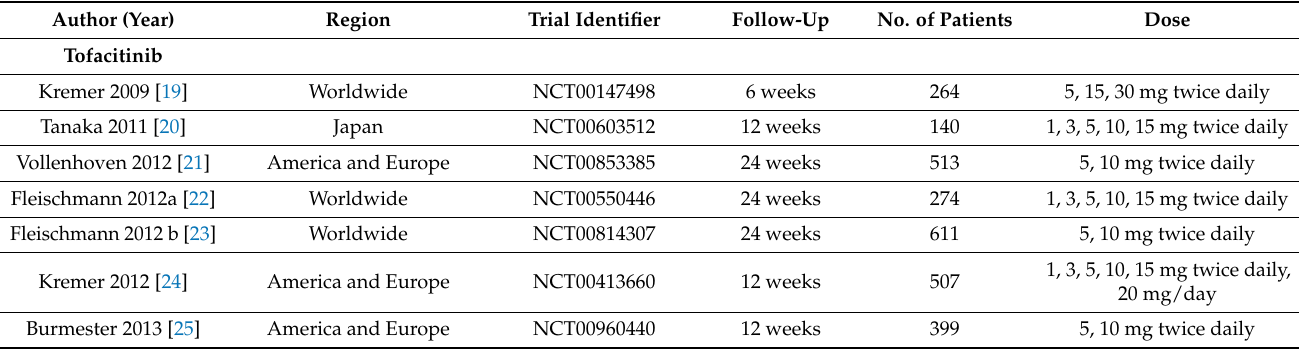
Table 1. Characteristics of included trials. Only data including placebo and the doses of interest are selected; therefore, the selected study duration is different from the original